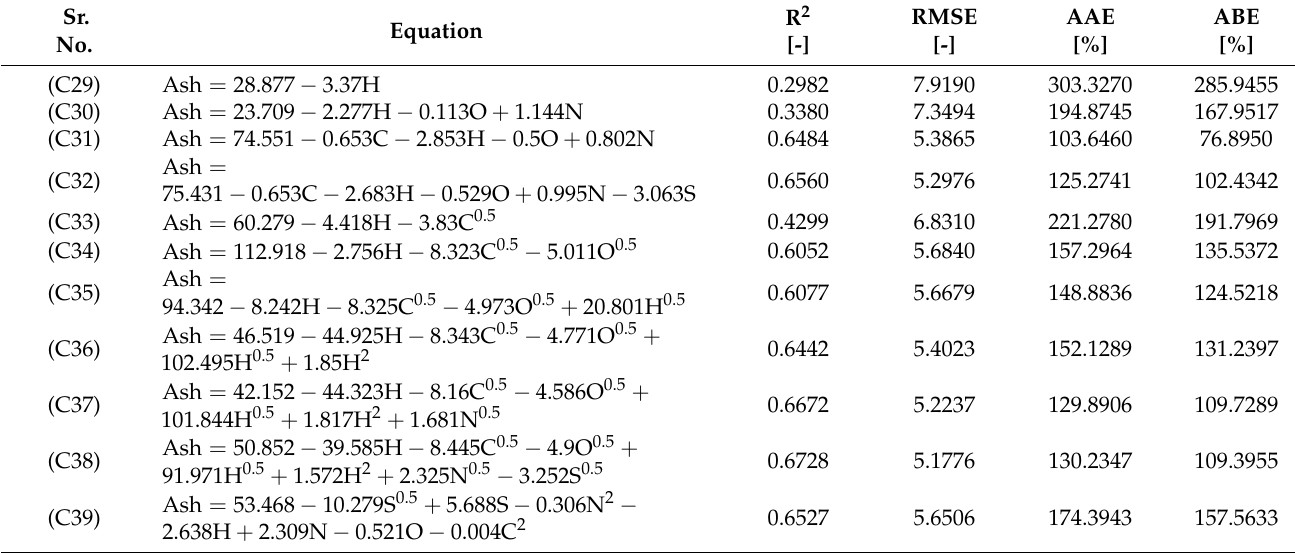
Table 5. Correlations used for predicting the Ash of biomass based on element analysis.